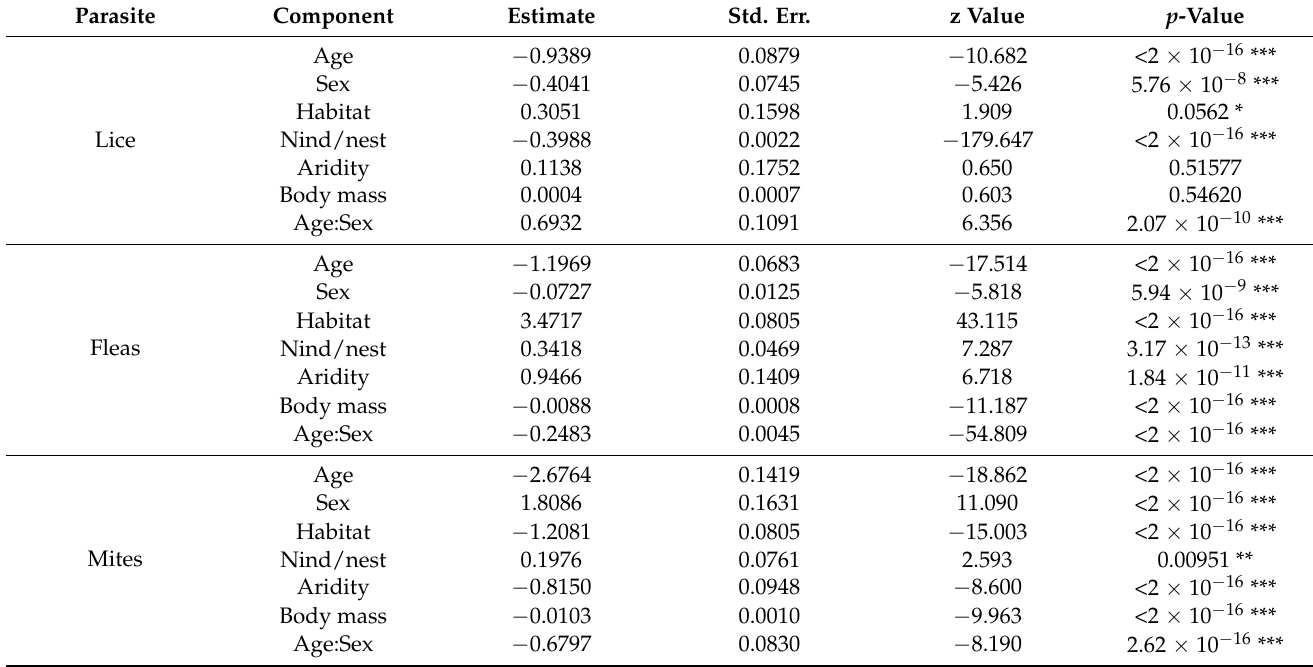
Table 2. Results of the estimated coefficients of the gllvm model.